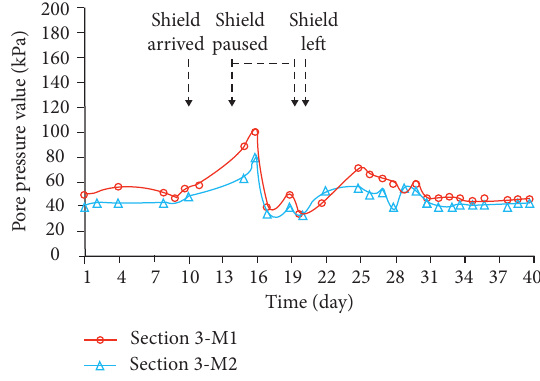
Figure 5: Curves of the pore pressure in Section 3.